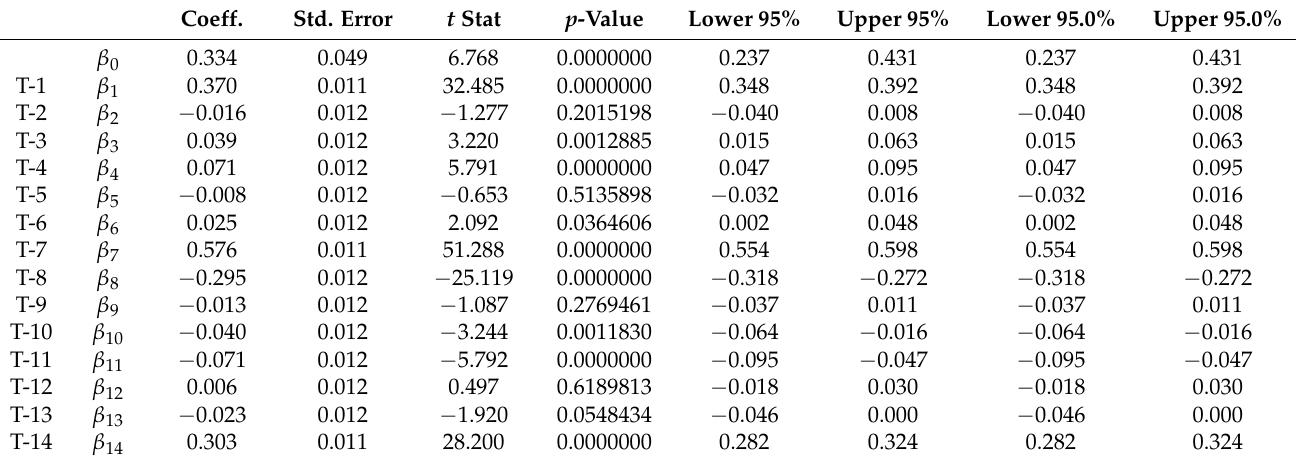
Table 1. Regression Statistics. R 2 = 0.778.